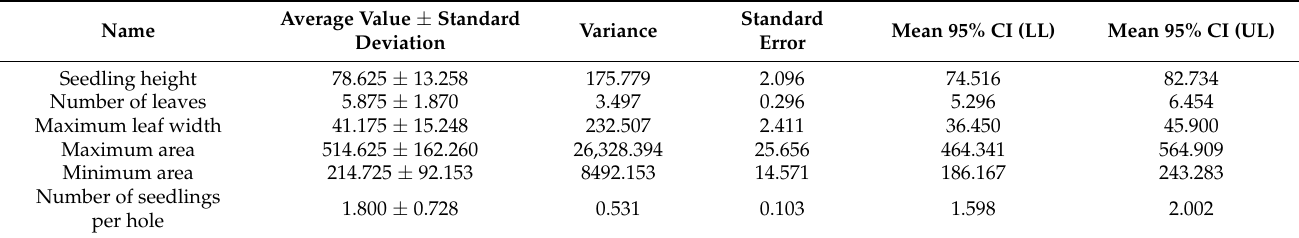
Table 2. Morphological characteristic of rape blanket